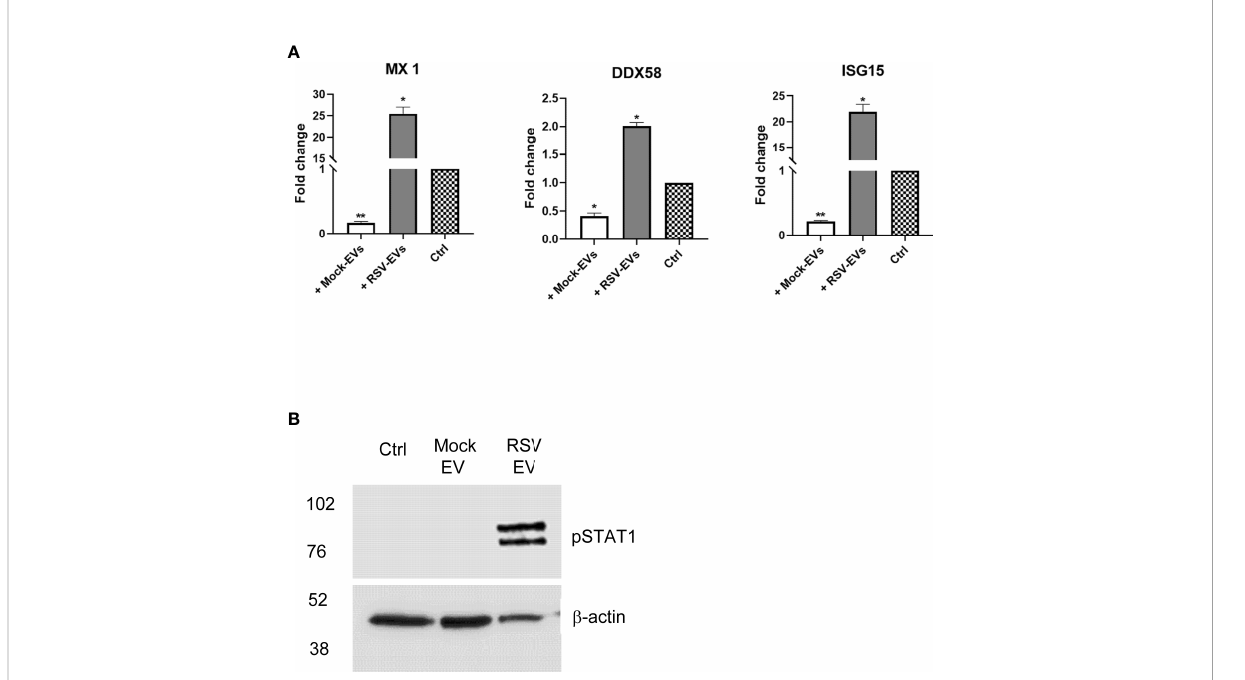
FIGURE 4 A549 cells were treated with Mock- or RSV- EVs (15 m g) for 24 hours and harvested to either extract total RNA or to prepare total cell lysates.A549 control cells with no EVs treatment are represented by checkered bar plot (A) . RNA extracted from A549 mock cells with or without EV treatment was subjected to RT-qPCR to measure the expression of antiviral genes MX1, DDX58 and ISG15. Fold changes in antiviral gene expressions were determined by 2- DD CT method and represent mean ± SEM normalized to 18S. Cell treated with RSV- or Mock- EVs versus mock cells (* p value < 0.05; ** p value < 0.01). Data represents the average of three independent experiments. (B) . Total cell lysates were subjected to western blot analysis using an antibody anti-phospho-STAT1 (pSTAT1). Membrane was stripped and re-probed with anti- b -actin for loading control. Western blot fi gure is representative of two independent